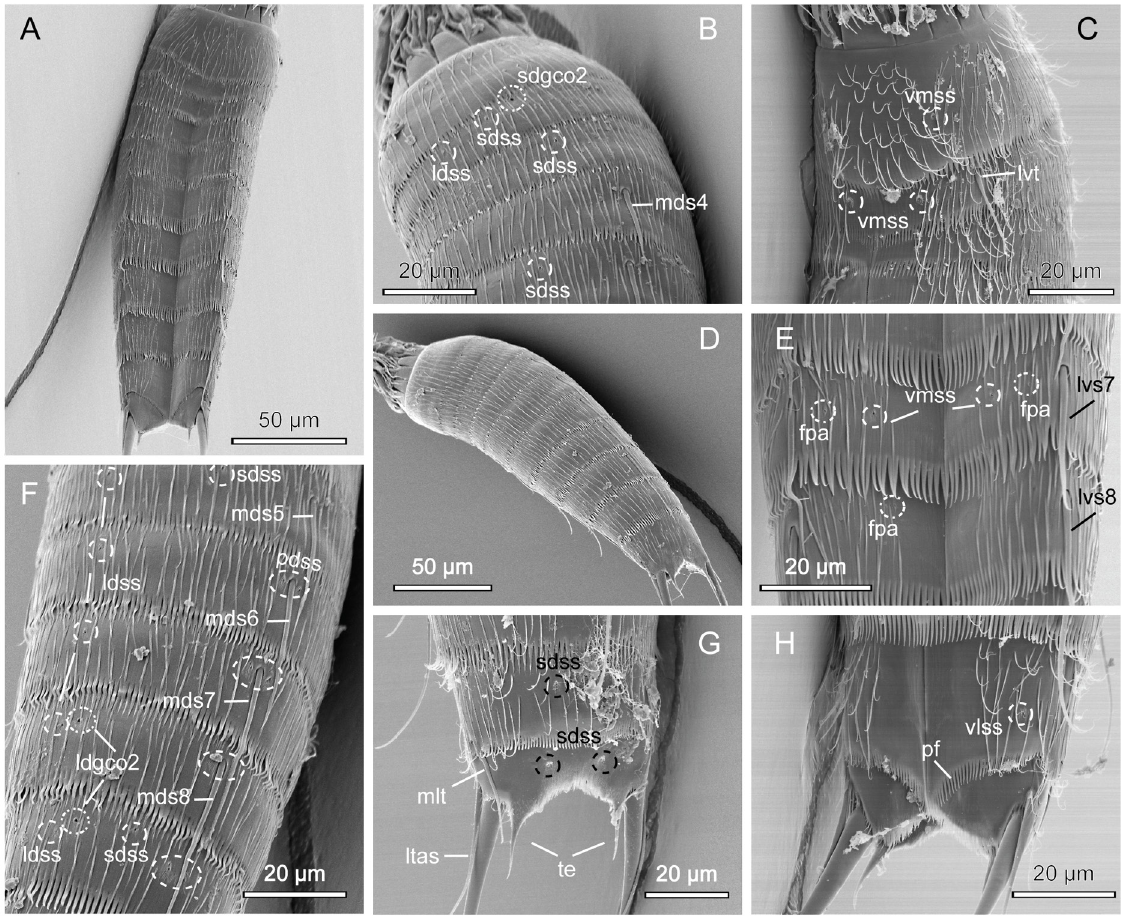
Fig. 35. Scanning electron micrographs showing overviews and details of Echinoderes sp. aff. E. lupherorum . A . Ventral overview. B . Segments 1 to 5, dorsolateral view. C . Segments 1 to 3, lateroventral view. D . Laterodorsal overview. E . Segments 7 to 8, ventral view. F . Segments 5 to 9, laterodorsal view. G . Segments 10 to 11 of female, dorsal view. H . Segments 10 to 11 of female, ventral view. Abbreviations: see Material and